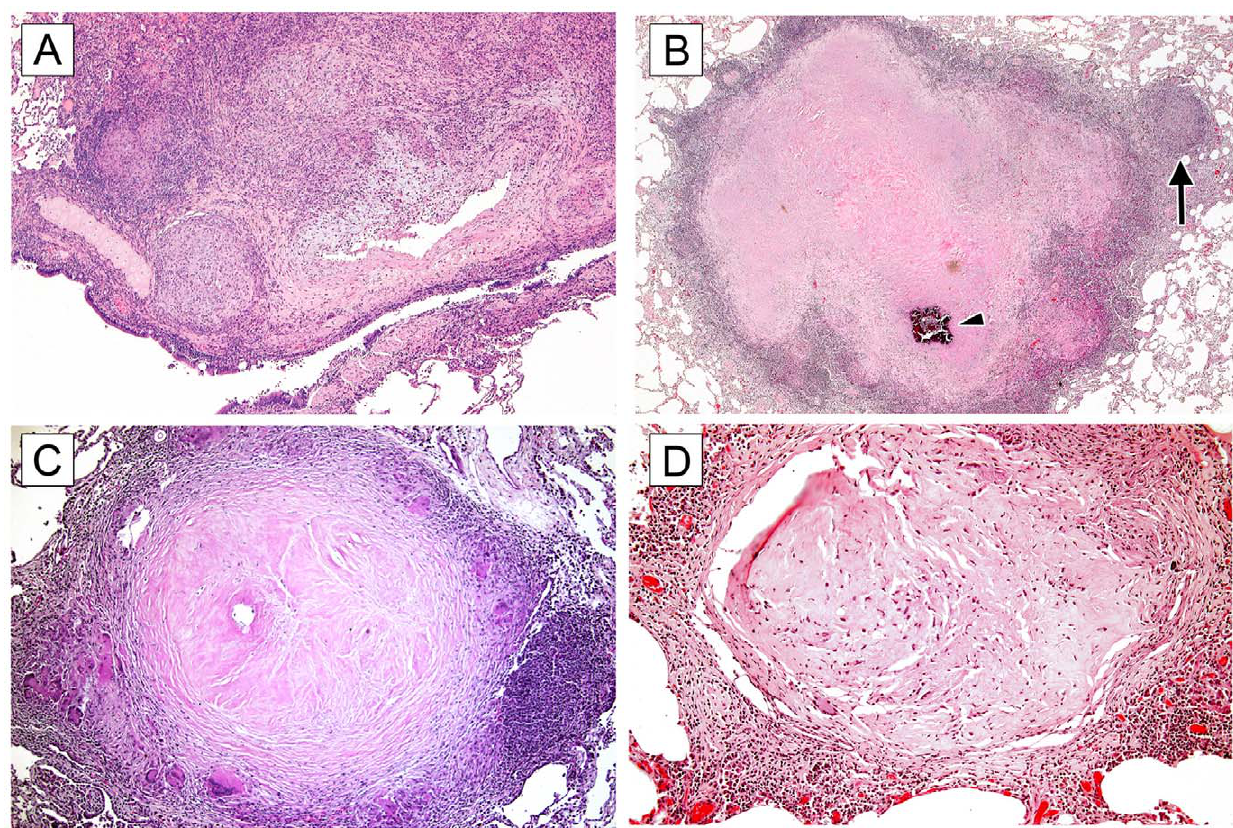
Figure 5. Histopathology associated with co-infected monkeys. A. Actively disseminating tuberculous disease characterized by granulomatous inflammation infiltrating into the wall of a large bronchus and adjacent vessel. Hematoxylin and eosin (H&E) stain, 5 6 magnification. B. A ‘‘satellite’’ nodule (arrow) comprised of non-necrotizing granulomatous inflammation extends from the outer margin of a more chronic caseous granuloma, suggesting loss of immunological containment and reactivation. Arrowhead indicates mineralized area. H&E stain, 2 6 magnification C. A chronic granuloma with extensive central fibrous organization in conjunction with a dense circumscribing margin of peripheral fibrosis. H&E stain, 10 6 magnification. D. A solid fibrotic granuloma comprised of maturing fibroblasts depositing a collagenous matrix. H&E stain, 10 6 magnification.